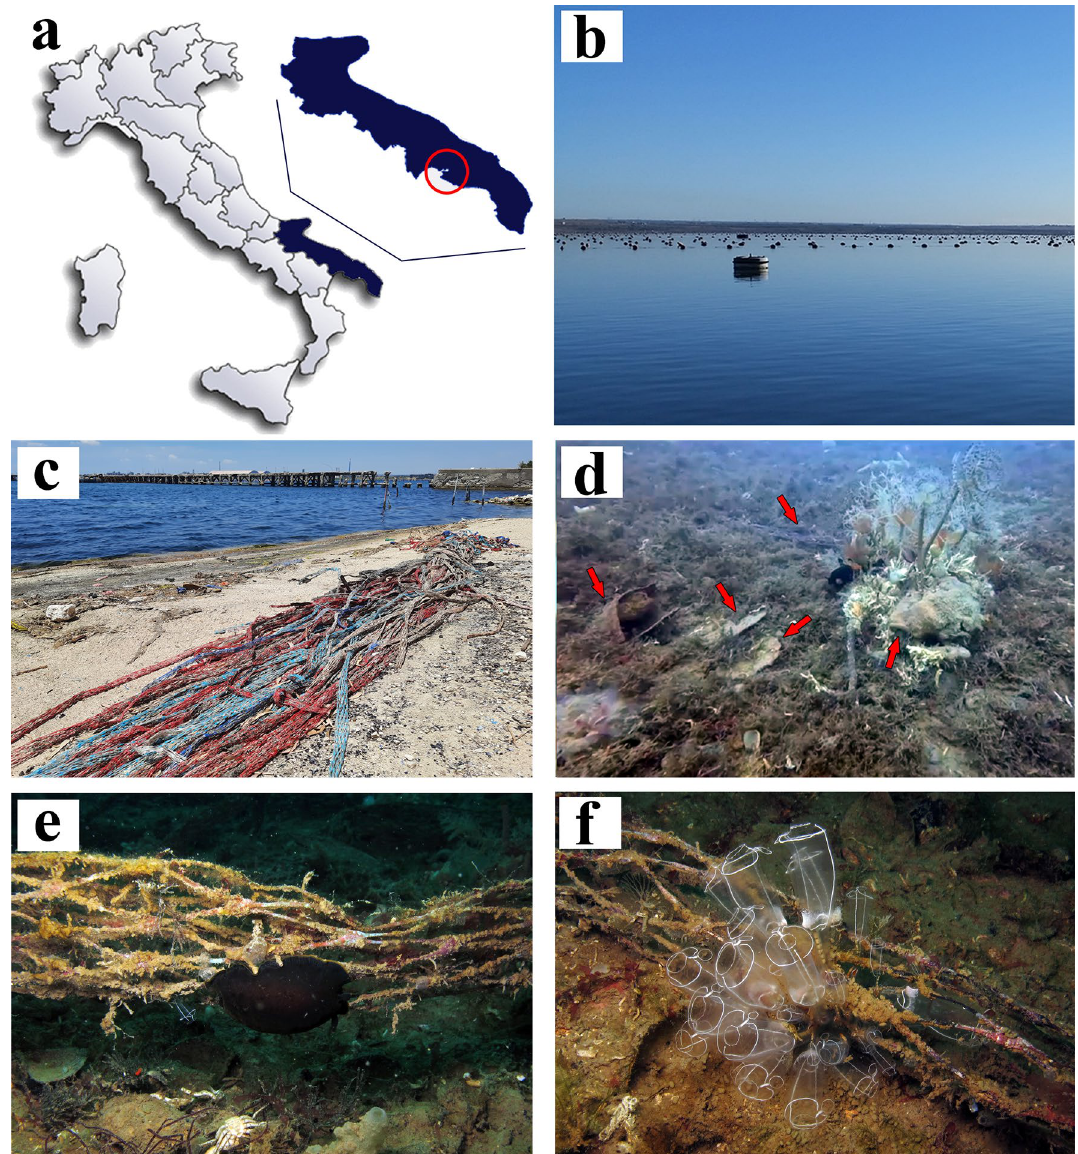
Figure 1. Sampling locality objects of the present study. ( a ) Map of the sampled area in Apulian Ionian Sea with the Mar Piccolo highlighted by the red circle (Taranto, Southern Italy). Map was obtained using Microsoft Paint 3D Version 6.2105.4017.0. ( b ) External photo of the buoy indicating the submerged underwater site (40° 29 ′ 05.1 ′′ N 17° 15 ′ 08.3 ′′ E). ( c ) Fishing nets along the beach. ( d ) Polluted environment characteristic of Mar Piccolo (9 m depth). ( e ) Fishing net with the sea slug Dendrodoris limbata (Cuvier, 1804) crawling on it. ( f ) Sessile tunicate, Clavelina lepadiformis (Müller, 1776), living on a fishing net in the sampling site. Red arrows indicate the plastics present in the studied